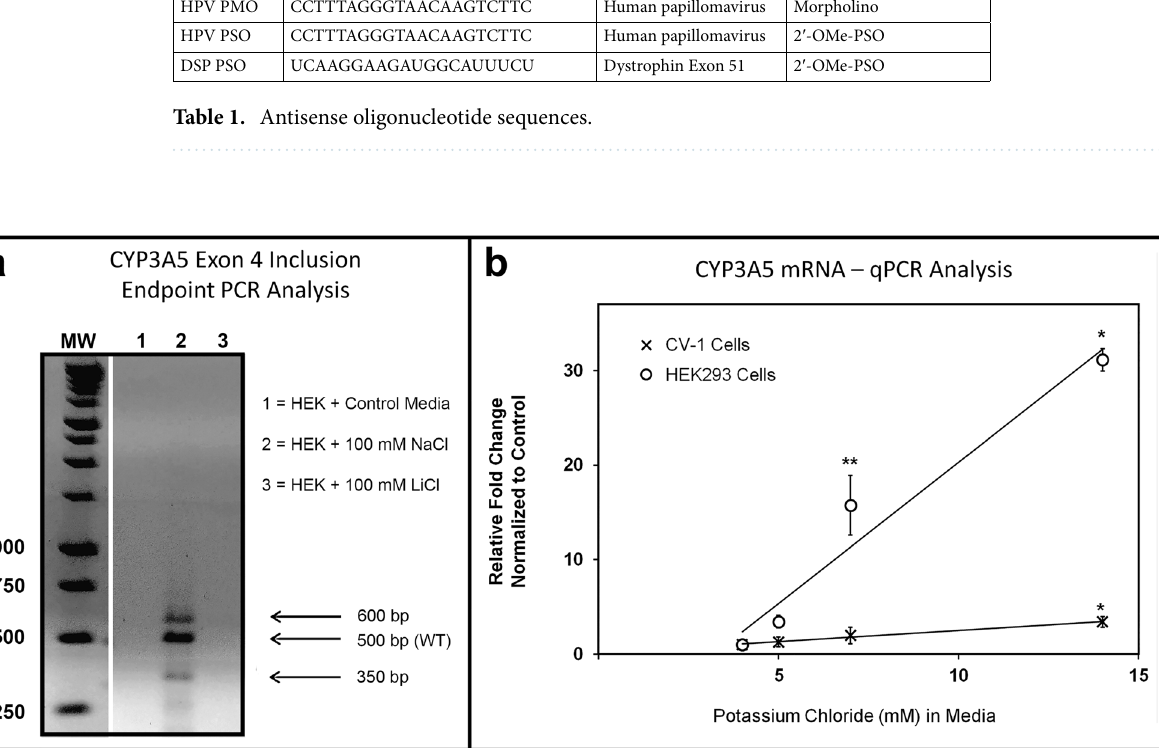
Figure 2. Cation-specific Restoration of CYP3A5*3/*3 mRNA in HEK293 cells, but not CYP3A5*1/*1 CV-1 cells. ( a ) Endpoint PCR monitoring of CYP3A5 mRNA expression in HEK293 cells exposed to: 1 (control), 2 (NaCl enriched), and 3 (LiCl enriched) media revealed cation-specific induction of alternative gene splicing. Several lanes were removed from this original gel image to aid in the molecular weight interpretation shown here, and this gap is denoted by the white dividing line. ( b ) SYBR Green qPCR Analysis of CYP3A5 mRNA from HEK293 ( CYP3A5*3 ) and CV-1 ( CYP3A5*1 ) cells incubated with media supplemented with increasing amounts of (4, 5, 7, and 14 mM) of KCl. Normal DMEM media contains 4 mM